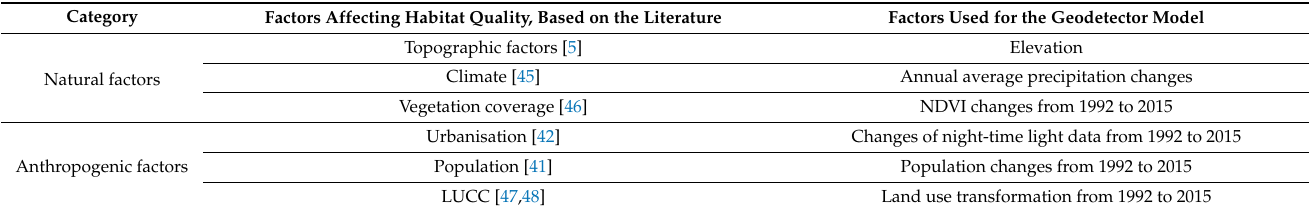
Table 1. Summary of factors affecting habitat quality based on the literature and factors used for the GeoDetector